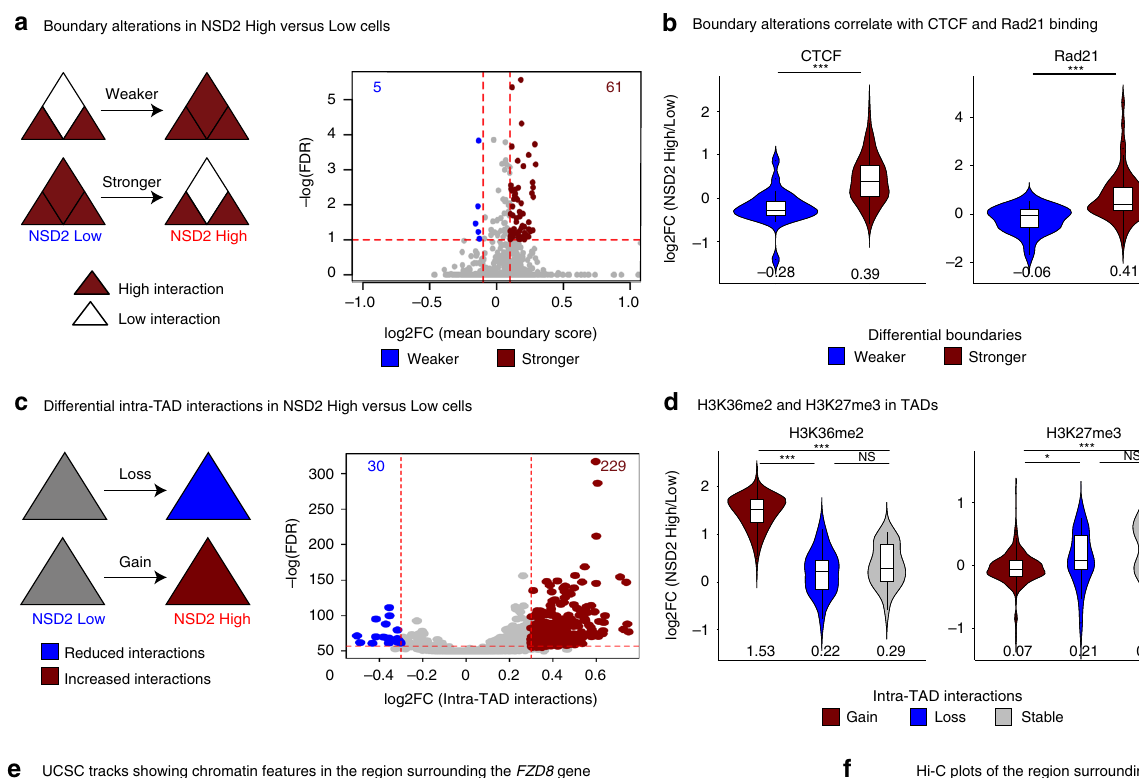
f UCSC tracks showing chromatin features in the region surrounding the FZD8 gene Hi-C plots of the region surrounding the FZD8